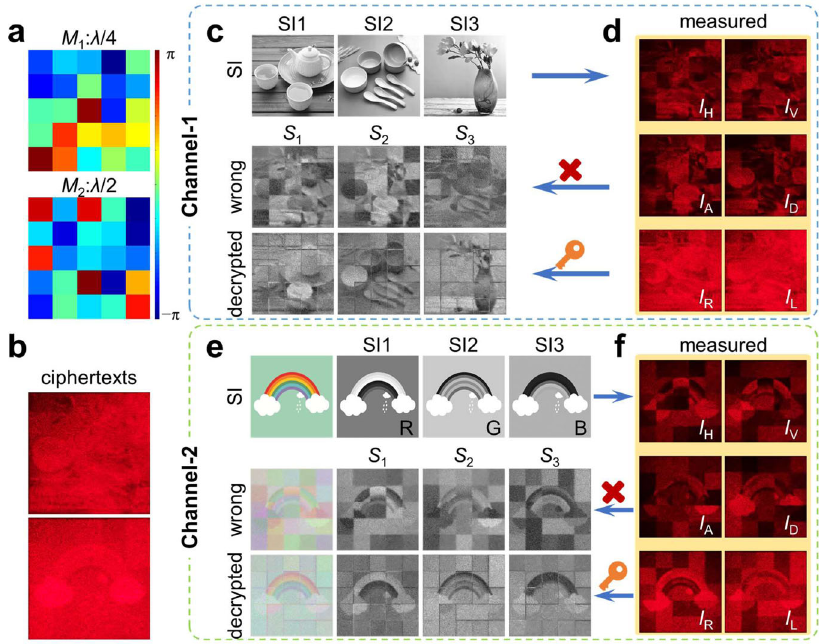
Fig. 3 | Mueller matrix encryption. a Random direction in Mueller matrices of pixelated wave plates. b Measured ciphertext (total intensity) patterns. c – f Decrypted results with and without the secret key. Three grayscale images and an RGB color image are encrypted into Stokes vectors (SI1, SI2, SI3) T ( fi rst rows of c and e ) and then transformed into vectorial ciphertexts after a